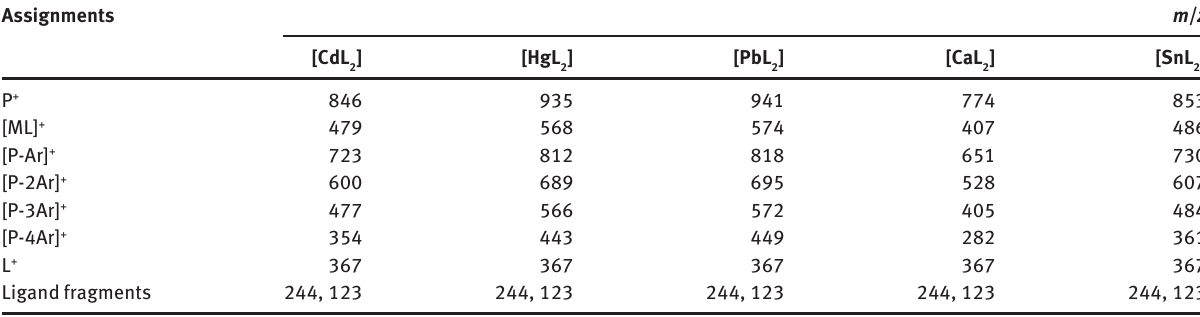
Table 3 Mass spectral data of the metal complexes of curcumin.